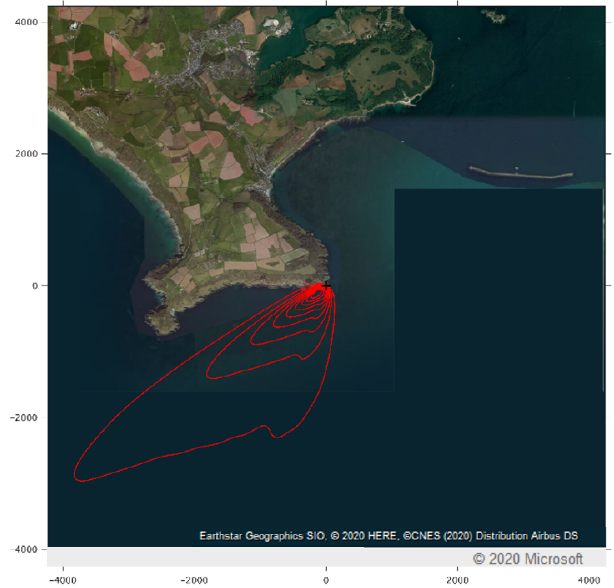
Figure 9. Flux footprint climatology for all 20min data that passed the selection criteria output from the Kljun et al. (2015) footprint model. Each contour represents the area contributing 10% of the observed flux, up to 90% for the outermost contour. A binary land/sea classification estimated a mean land contribution of